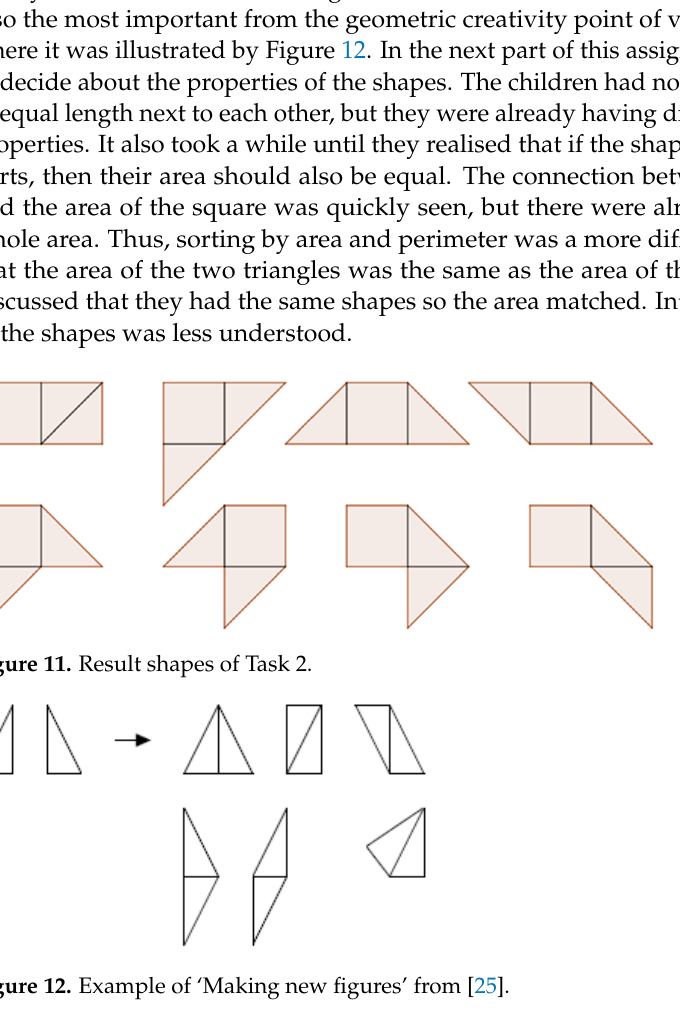
Figure 13. Manifestation of free creativity. Most students found the required rectangles in Task 4 with different perimeters, but at first glance, it was not clear for some of them that the areas of these shapes (Figure 14) are equal. After comparing the equal parts in the two shapes, they accepted this fact easily. Figure 14. Rectangles with different perimeters. Task 5 served as a propaedeutic question to learn about more geometric shapes, such as trapezoid and parallelogram. The students put together square and rectangular shapes and recognised the new quadrilaterals and learned their names (Figure 15).